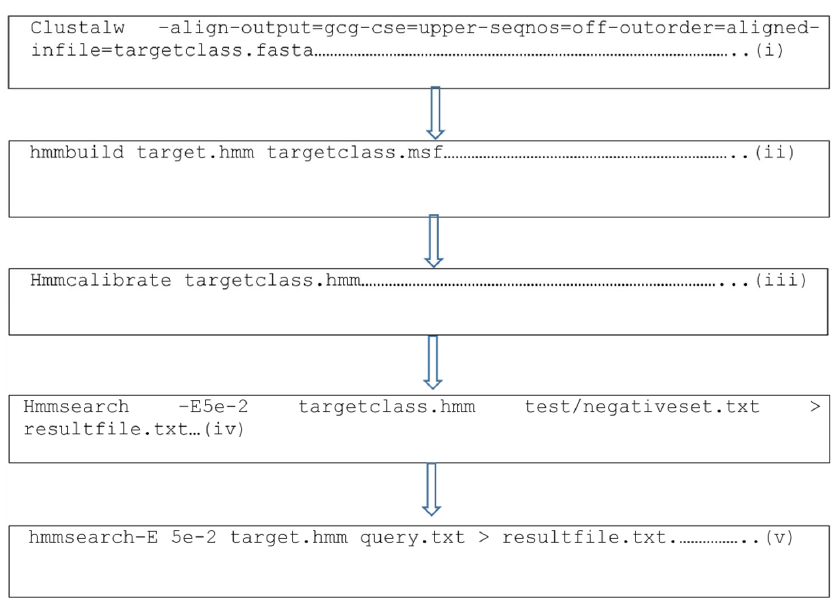
Figure 1. Representative codes for the generation of the parental putative antimicrobial peptides from the HMMER algorithm, a machine learning tool, where ( i ) indicates the generation of Clustal for the training datasets which yields the msf file; ( ii ) generates the hmm file from the msf file using hmmbuild; ( iii ) calibrates the hmm profile; ( iv ) searches for matching motifs in the test or negative datasets; and ( v ) searches for motifs in proteomes of other organisms for the discovery of new antimicrobial peptides.